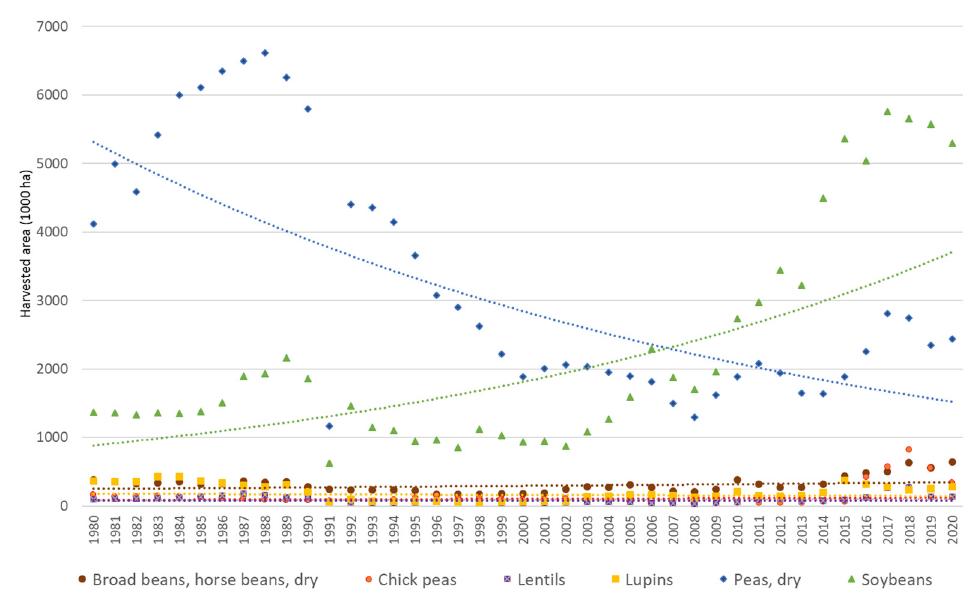
Figure 2. Harvested area of protein crops and soybean in the EU between 1980–2020 [35].